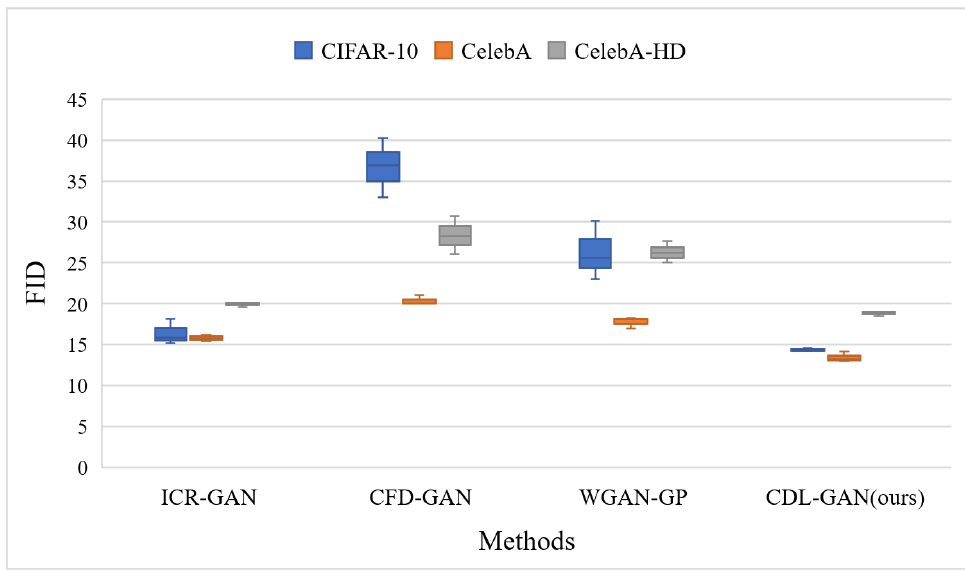
Figure 2. FID scores (lower is better) for CDL-GAN and the existing models for different datasets. The FID scores in each dataset with 5 validations for different models.